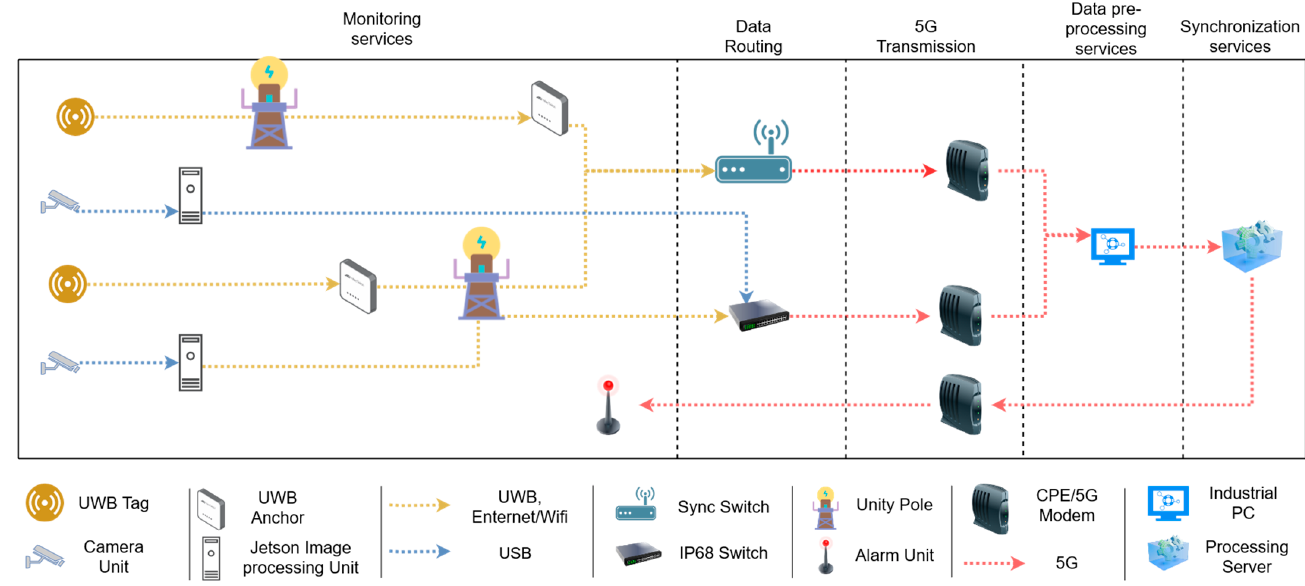
Figure 10. Site architecture of